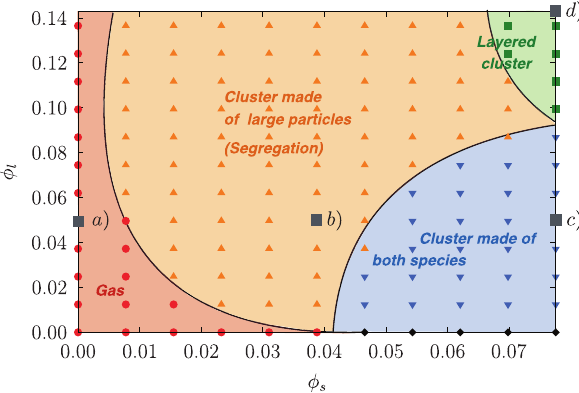
Fig. 2 Phase diagram obtained via numerical simulations by varying ϕ fi lling concentrations of ϕ s and l . Clustering of the individual species is detected using a statistical test of uniformity of the particle ’ s positions in the cell. Different colours and symbols are used depending on the detected regime. Solid curves serve solely as guides. Large square symbols correspond to experimental condi- tions Fig. of the diagram (red). Segregation is observed for a wide range of fi llings in the central region of the diagram (orange). Clustering of both particle species is encountered for high numbers of small grains, in the lower right corner (blue). Stripy patterns can only be found for the highest fi lling values, in the upper right corner (green). Snapshots of all presented experiments as well as corresponding simulations are compared in Fig. 1. Large beads are highlighted with coloured circles. Filling increases from left to right and the sinusoidal driving is along the horizontal direction. We observed, for the fi rst time, segregation coupled to complex